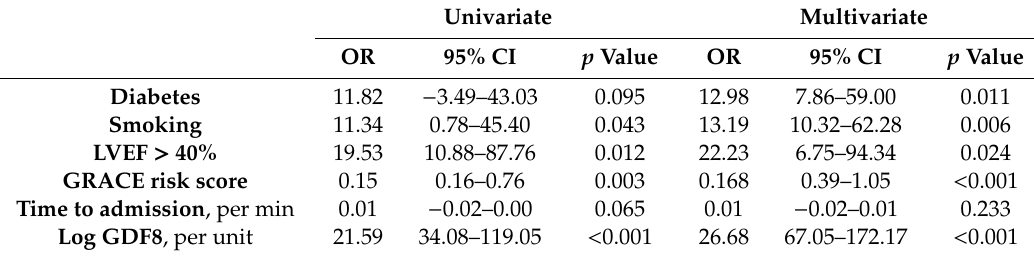
Table 4. Logistic regression analysis for prediction of troponin I